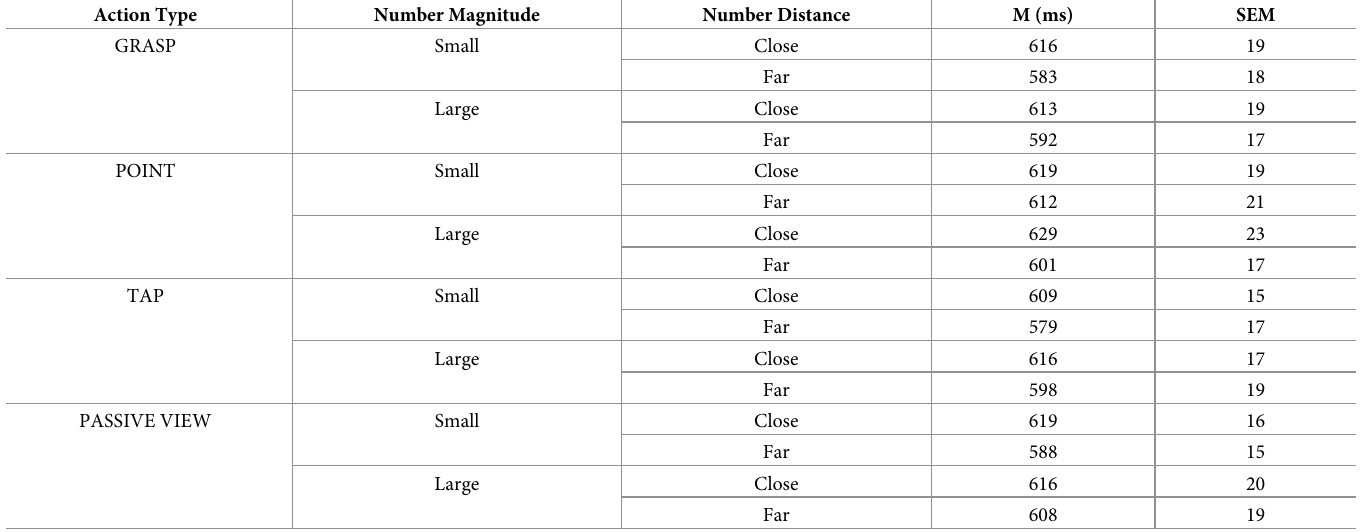
Table 1. Mean RTs and SEM for each condition.